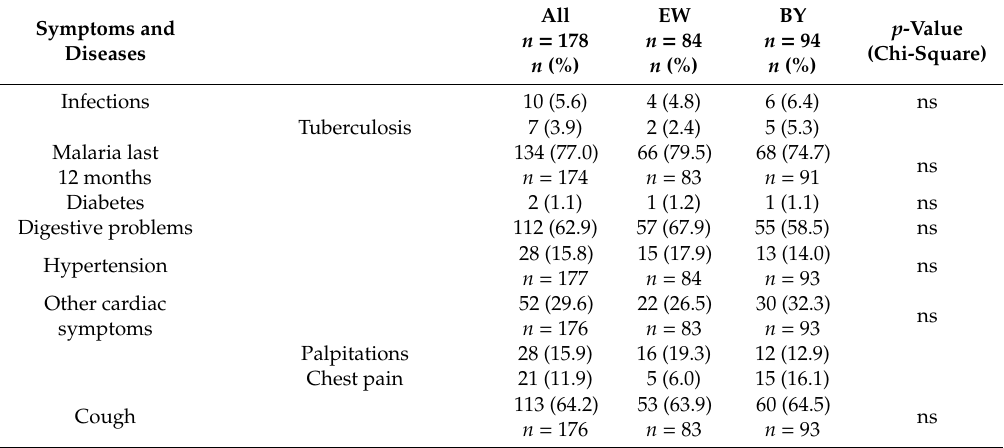
Table 3. Selected symptoms and diseases of the e-waste workers and bystanders on the Agbogbloshie scrap